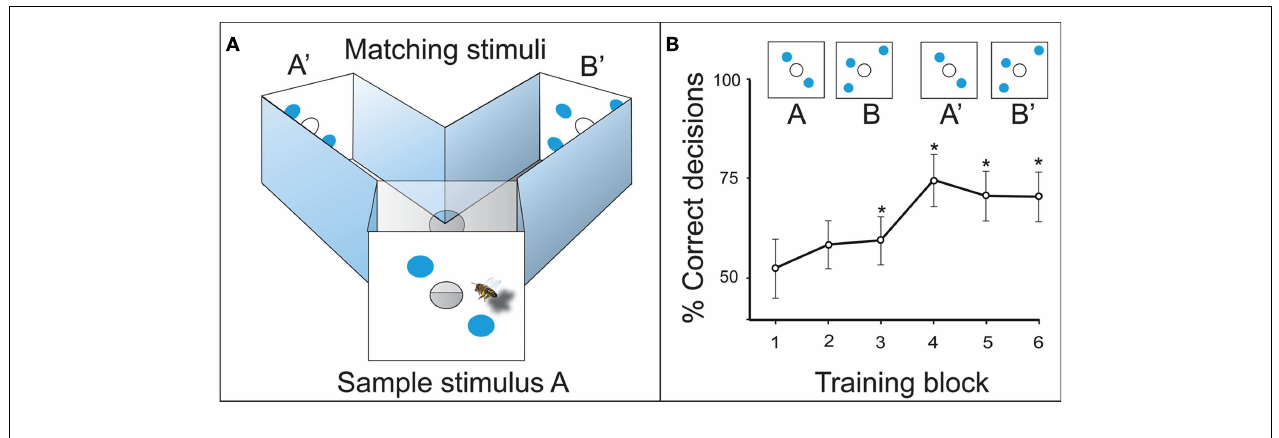
example. (B) Learning curve of the DMTS experiment. *Denotes a preference for the matching stimulus significantly different from random